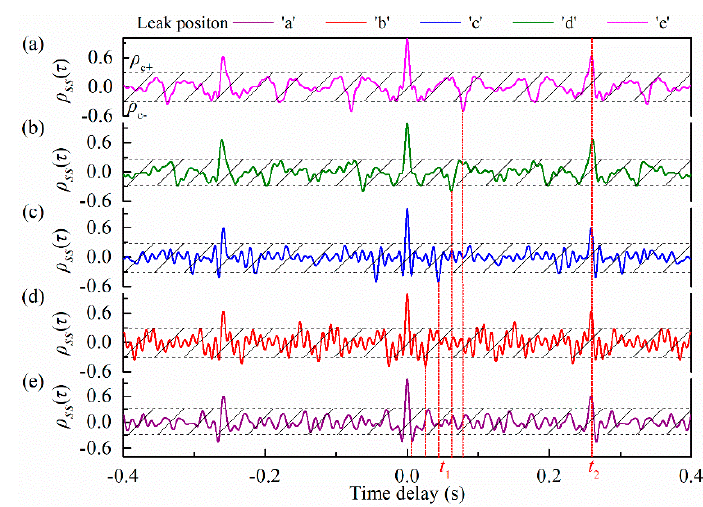
Figure 12. Autocorrelation coefficients of leak acoustic signals generated at ( a ) position e, ( b ) position d, ( c ) position c, ( d ) position b, and ( e ) position a.